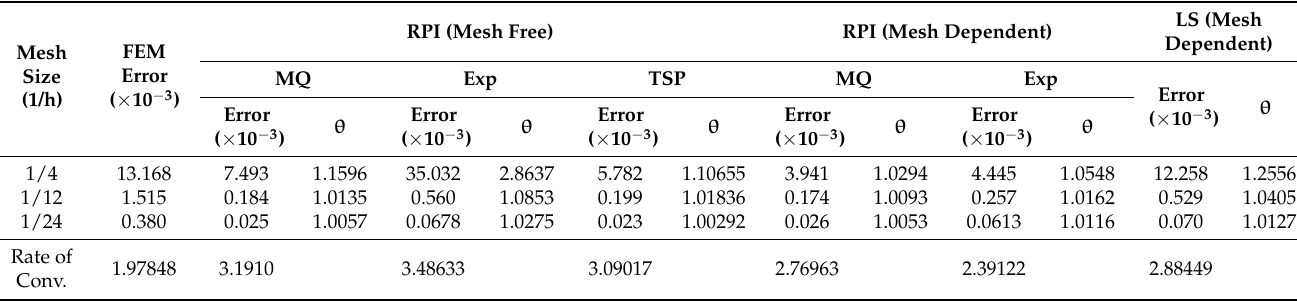
Table 5. Error convergence and global effectivity ( θ ) obtained for RPI with radial basis function types and least square based displacement recovery techniques (quadratic triangular, energy